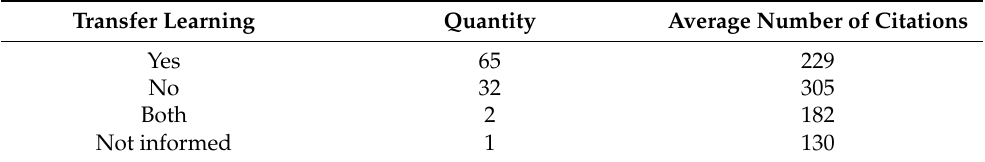
Table 9. Transfer